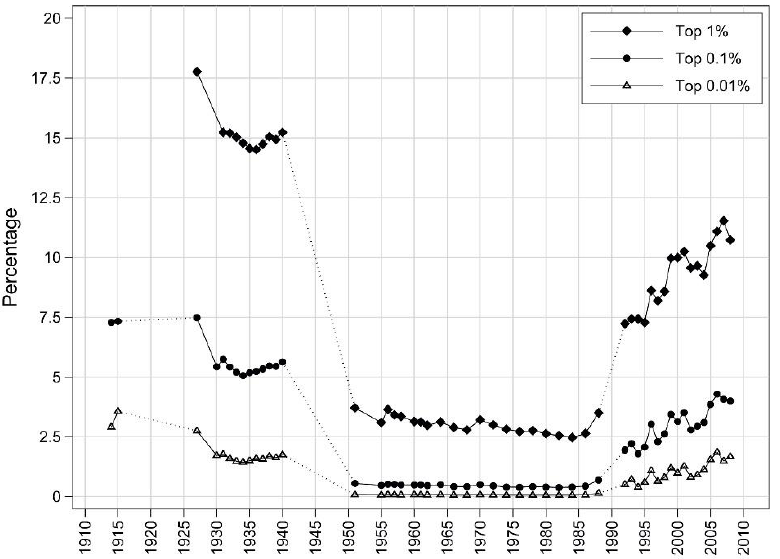
Figure 1. The income share of the top 1%, 0.1% and 0.01% has increased considerably after transition to capitalism in Hungary [17].